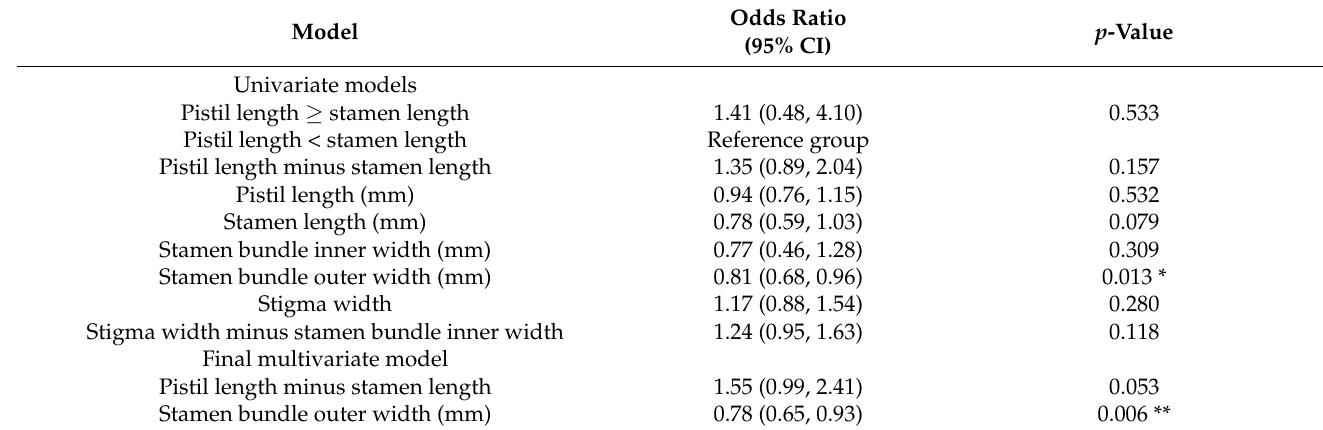
Table 5. Effects of phenotypic traits on the yield of tea varieties in